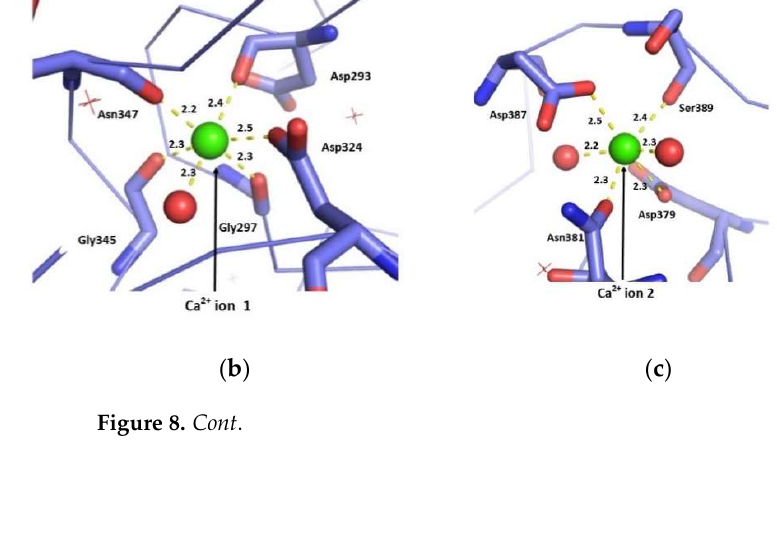
Figure 7. The H1N1 NA tetramer structure from HEK cell produced protein. The NA tetramer is made up of four monomers each related by a non-crystallographic four-fold axis of symmetry. The top left monomer is shown as a protein cartoon diagram in grey. The arrows represent β -strands and the spirals represent helical structure. Loops are shown as thin lines, connecting the β -strands and α -helices. The 8 disulfide bonds are shown as pink sticks. The top right monomer is shown as a protein cartoon diagram, with rainbow colouring from the N-terminus (blue) to C-terminus (red). The bottom left monomer is shown as a grey protein cartoon covered in a space filling molecular surface. The bottom right monomer is shown as grey cartoon, with the active site residues (Arg118, Asp151, Arg152, Arg224, Glu276, Arg292, Arg371, Tyr406) shown as blue sticks. The NA tetramer structure from HEK293-6E cell protein contains a total of 9 Ca 2+ ions, which are shown as green spheres.